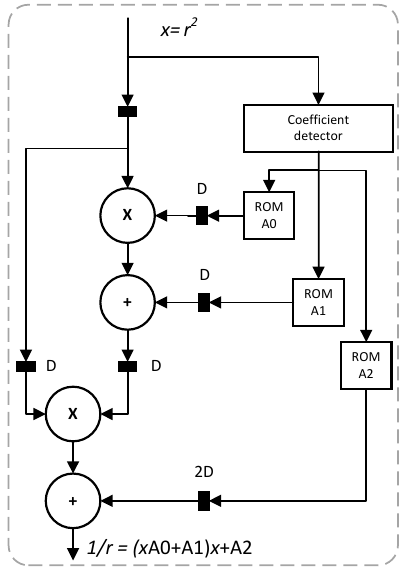
Figure 4. Givens Rotation (GR) systolic architecture based on hybrid PPA techniques.